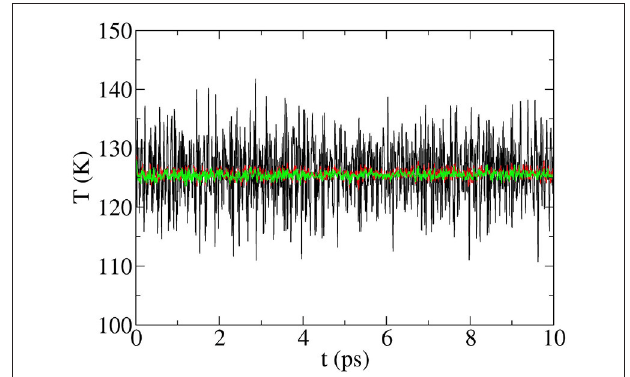
FIGURE 1 | Total temperature of the Si 200 H 32 supercell vs. time without averaging (black line) and after averaging over n = 50 (red line) and n = 100 (green line) initial microstates (see text). The non-equilibrium MD run includes a nanowire prepared at 100 K with a hot slice at 180 K. No thermostat is used and no thermalization run was done. The figure shows the temperatures vs. time starting with the first MD step. The time step is 1.0